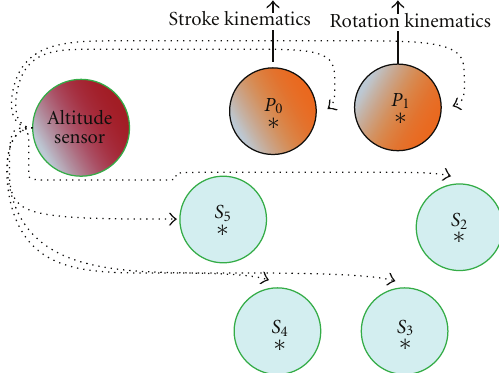
Figure 25: A pictorial representation of the reduced six-neuron architecture of the cruise controller referred in Figure 22. It should be noticed that the primary neurons and second secondary neuron retain their position in the network but the neurons 4, 5, and 7 from the original network are positioned in 3rd, 4th, and 5th locations respectively. The “ ∗ ” indicates that the neurons in this “dynamics- deprived neuron elimination” process-based architecture di ff er from the original neuron in the way that, their bias has been accounted for the eliminated neuron’s saturated output e ff ect on them. So, at least in steady state, this reduced network should perform functionally equivalent to the original